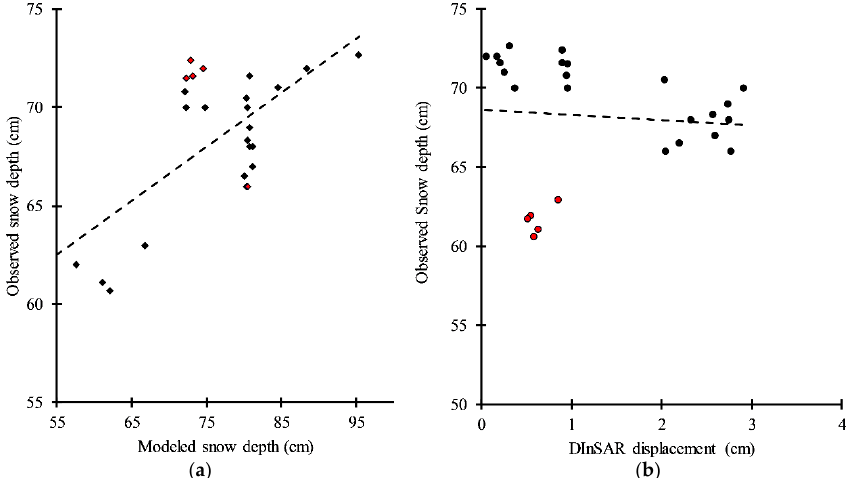
Figure 13. Correlation plots for the overall data, including February and March field measurement points for the estimated snow depth from the proposed method in ( a ) and DInSAR displacement in ( b ). The red points in both the plots show possible outliers. Table 4. Accuracy assessment of the mean DInSAR displacements and the estimated snow depth.